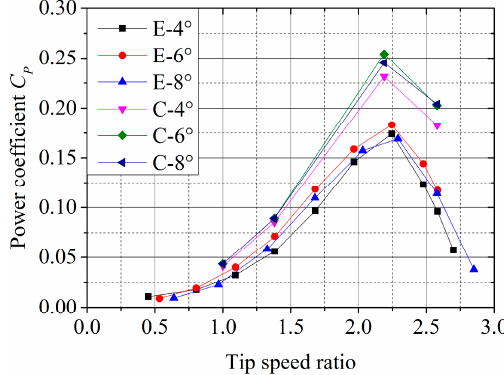
Figure 14. Power coefficients of rotor obtained from CFD simulations and wind tunnel experiments at the different pitch angles of β = 4°, 6° and 8°, respectively.